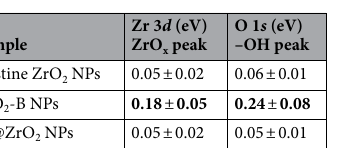
Table 2. Core-level shift of Zr 3d and O 1s peak during UV irradiation ( λ ≥ 225 nm). Significant values are in bold.